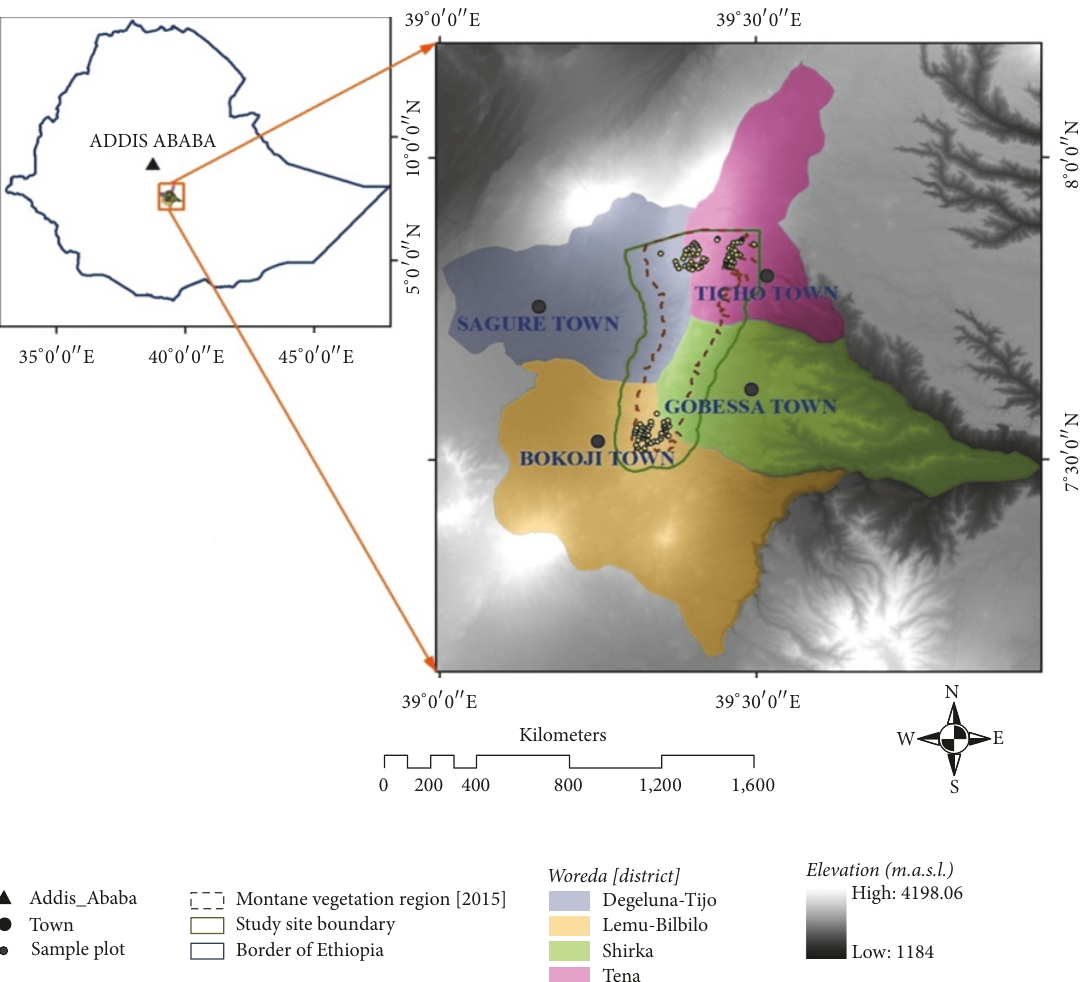
Figure 1: Location map of Arsi Mountains National Park (Galama